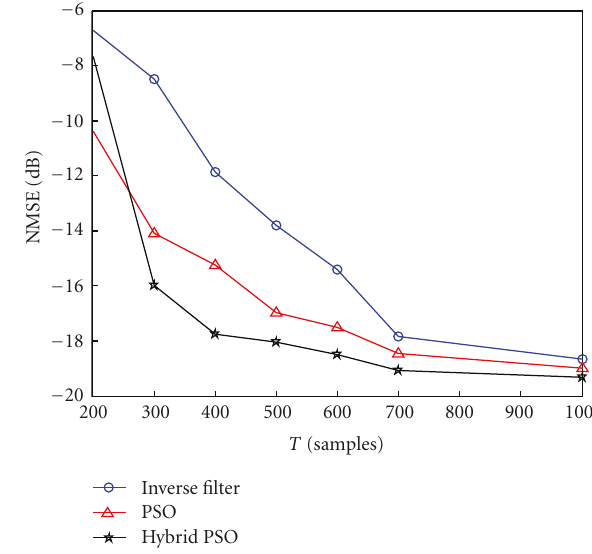
Figure 4: Comparison of NMSE of channel impulse response Estimations for di ff erent lengths of available data records(SNR = 20, equalizer length = 15).